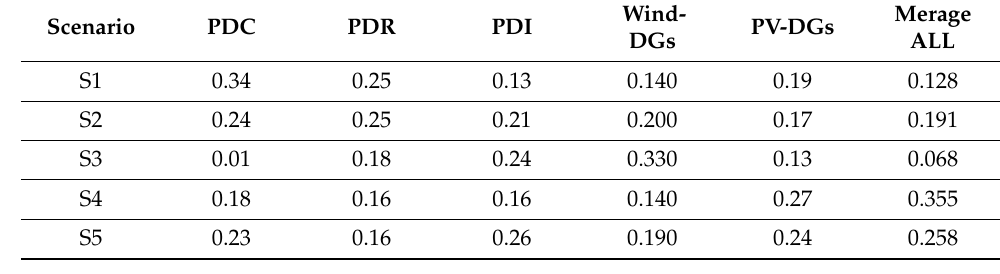
Table 2. Probabilities of different load profiles and DG profiles. Figure 5. 33 ‐ Bus IEEE distribution system.